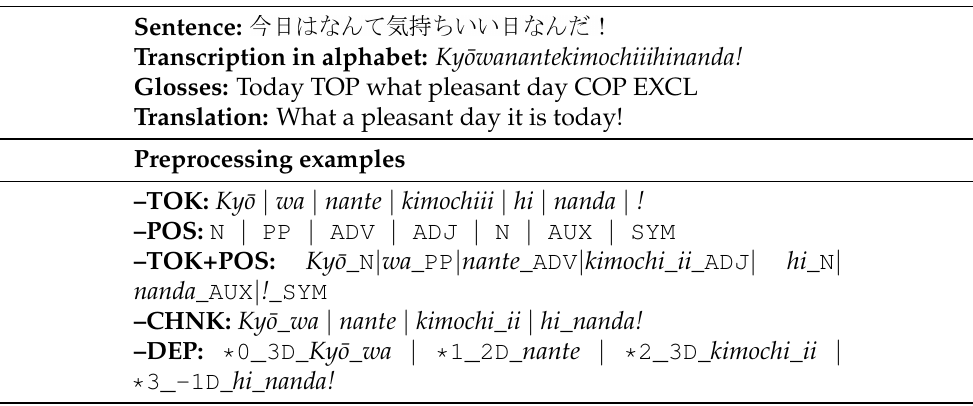
Table 5. Three examples of preprocessing of a sentence in Japanese; N = noun, PP = postpositional particle, ADV = adverb, ADJ = adjective, AUX = auxiliary verb, SYM = symbol, 1D, 2D, ...= depth of dependency relation, *0, *1, *2, ...= phrase